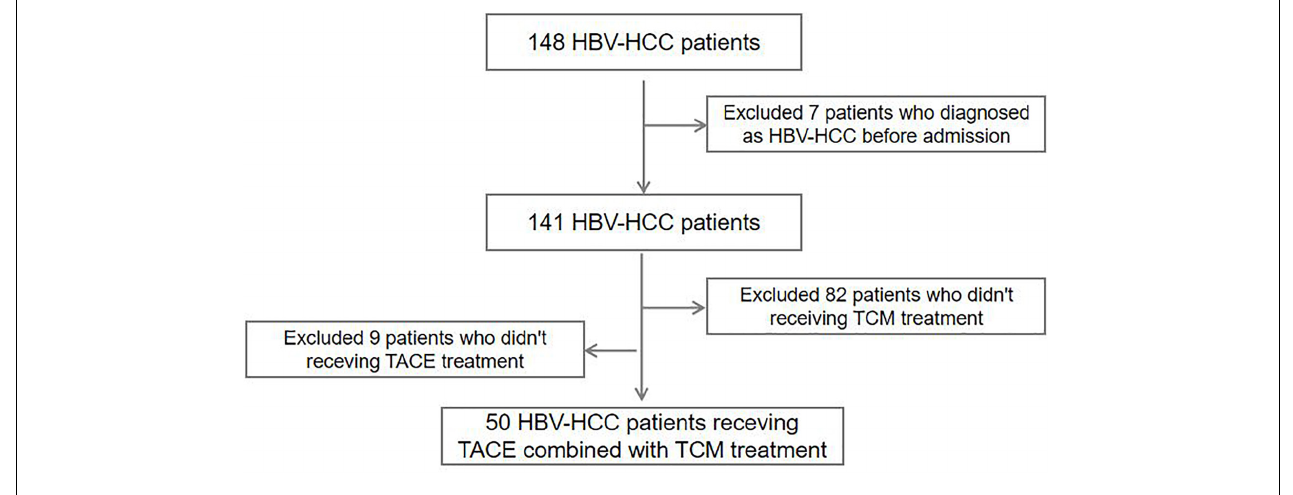
FIGURE 1 | Flowchart of patient enrolment.